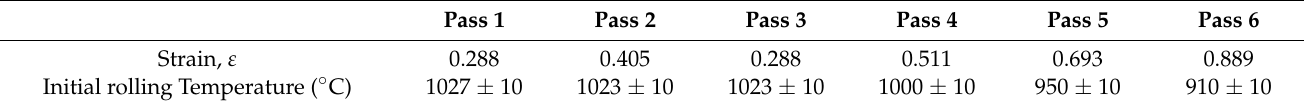
Table 1. Strain and initial rolling temperature used for laboratory hot-rolling. Pass 1 Pass 2 Pass 3 Pass 4 Strain,